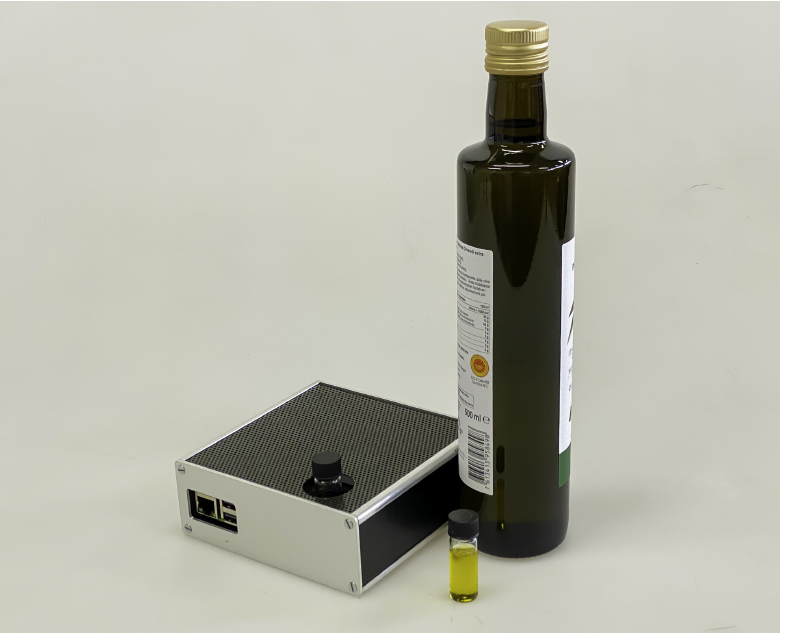
Figure 2. Photo of the minimalist fluorescence sensor with olive oil samples in the glass vials and a bottle of olive